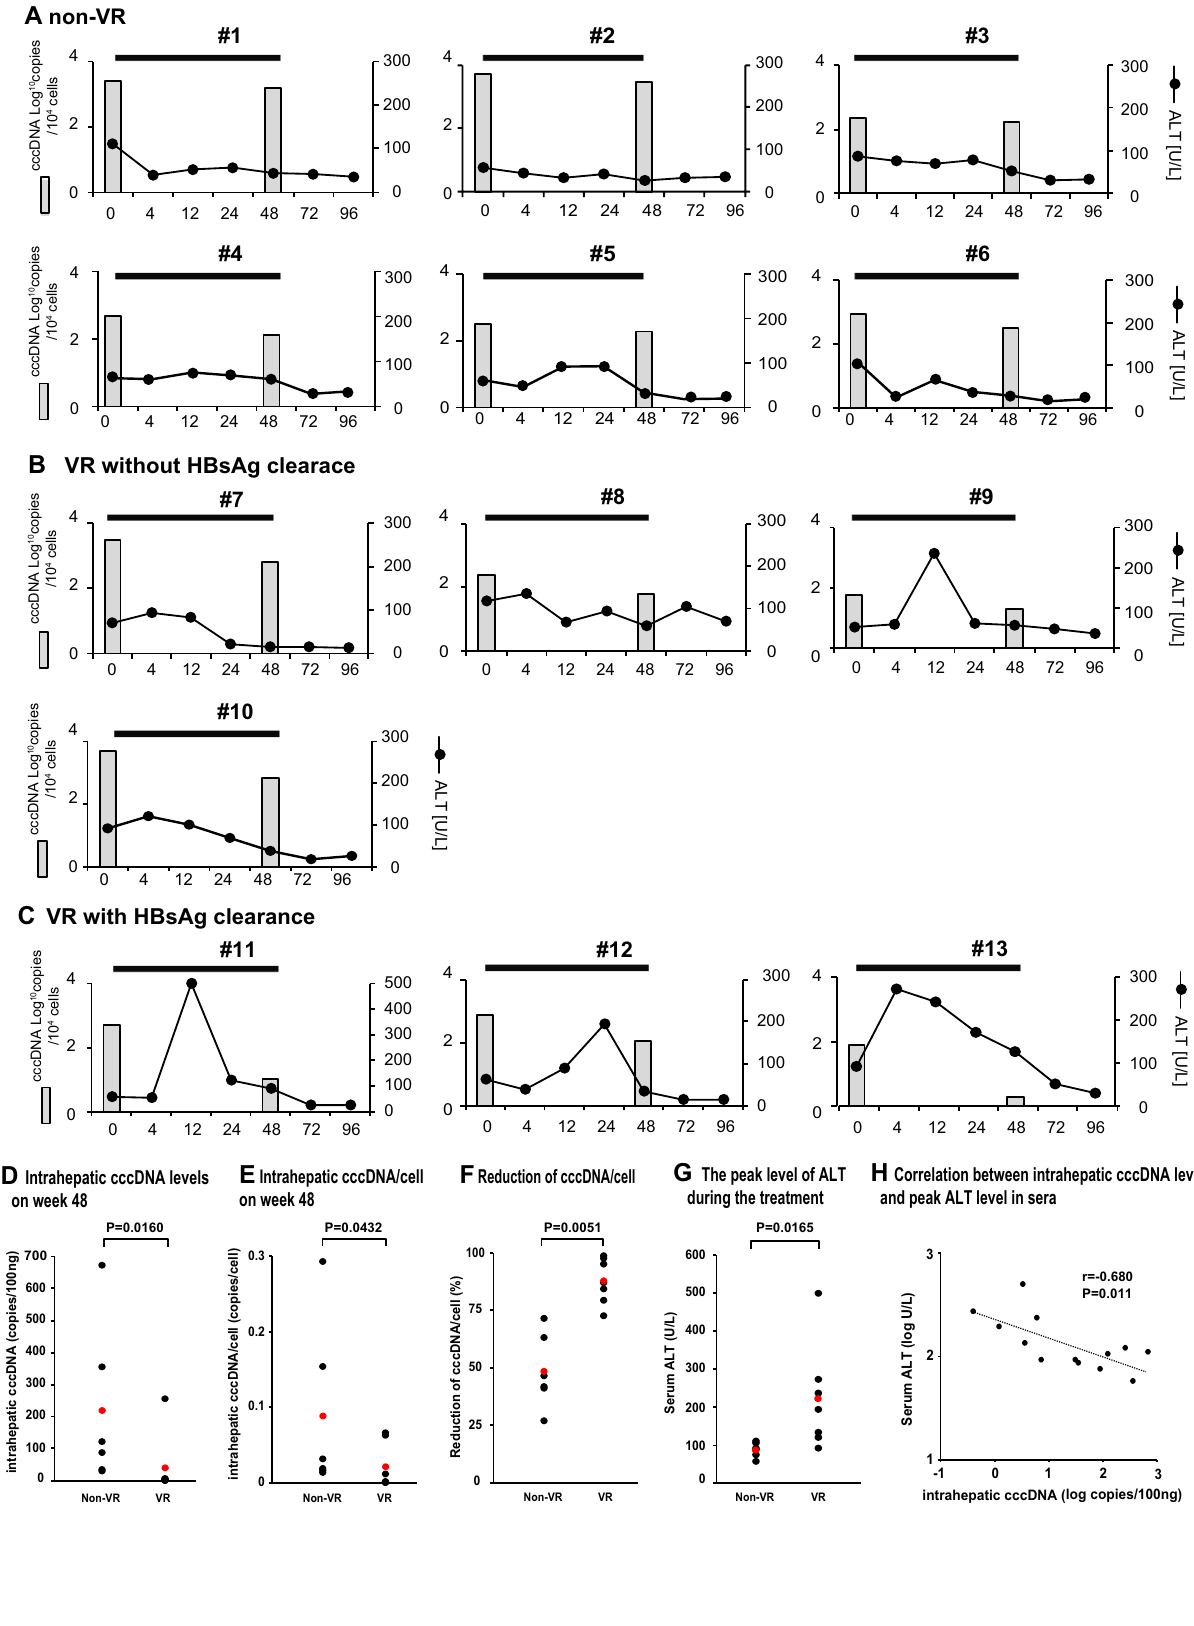
H Correlation between intrahepatic cccDNA level and peak ALT level in